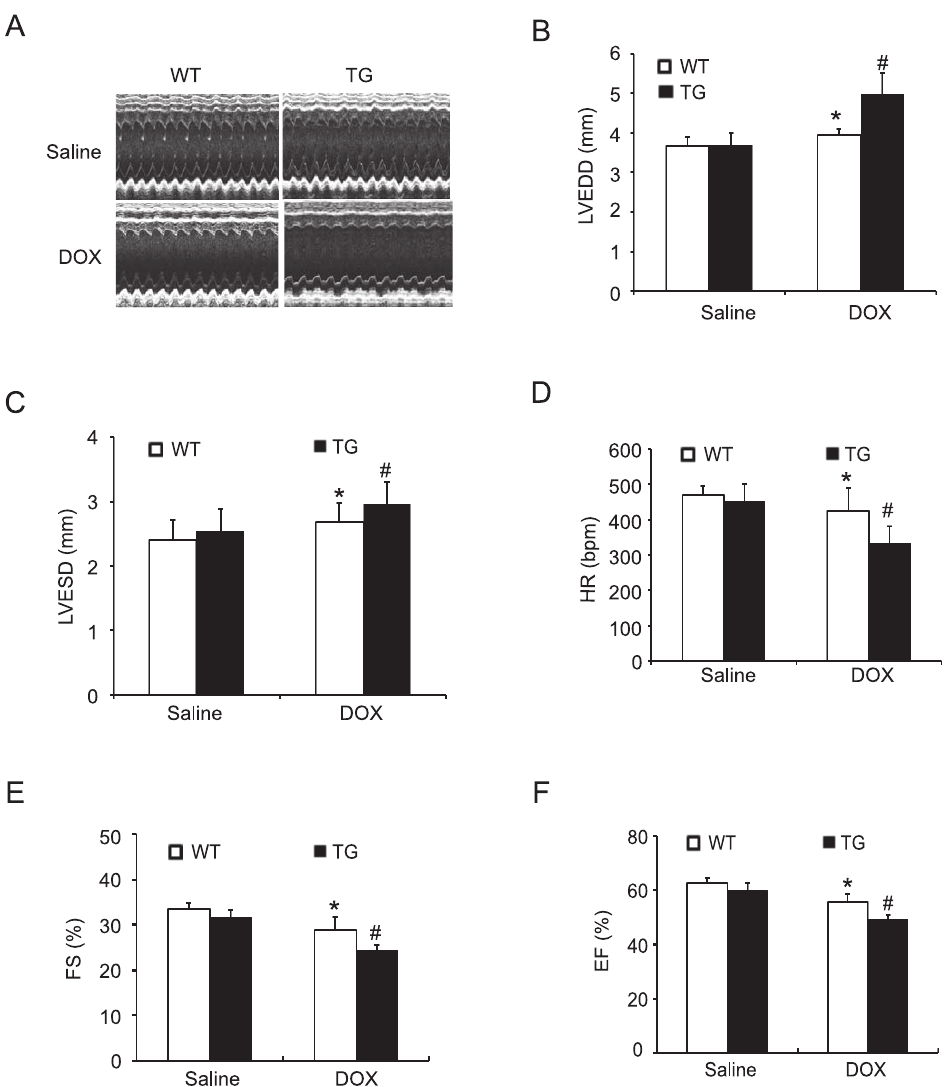
Figure 6. Overexpression of Nrdp1 reduces cardiac function after administration of DOX. (A) Representative M-mode echocardiograms of WT and Nrdp1 TG mice treated with saline or DOX. Quantitative group data for echocardiographic measurements: (B) HR; (C) LVEDD; (D) LVESD; (E) FS; and (F) EF. Data were from 10 mice in each group. * P , 0.05 vs WT + saline group, # P , 0.05 vs WT + DOX group. Abbreviations are defined in the text.